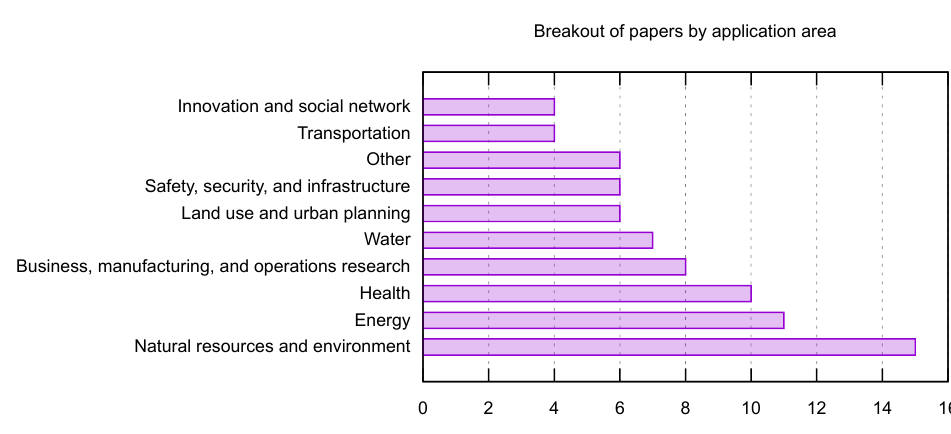
Figure 5. A breakdown of reviewed papers according to their research application